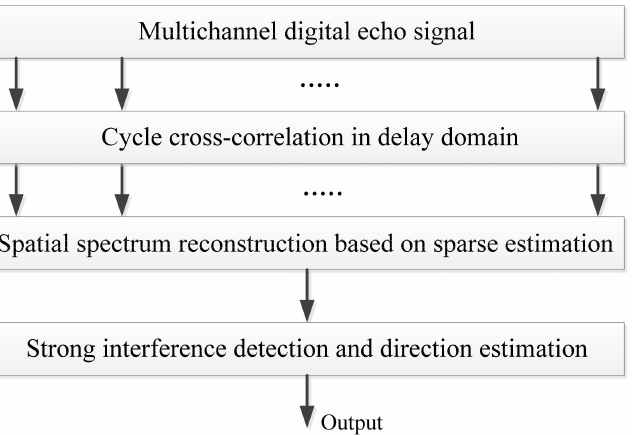
Figure 4. Strong disturbance direction and energy estimation based on the OFDM cyclostationary characteristics and sparse